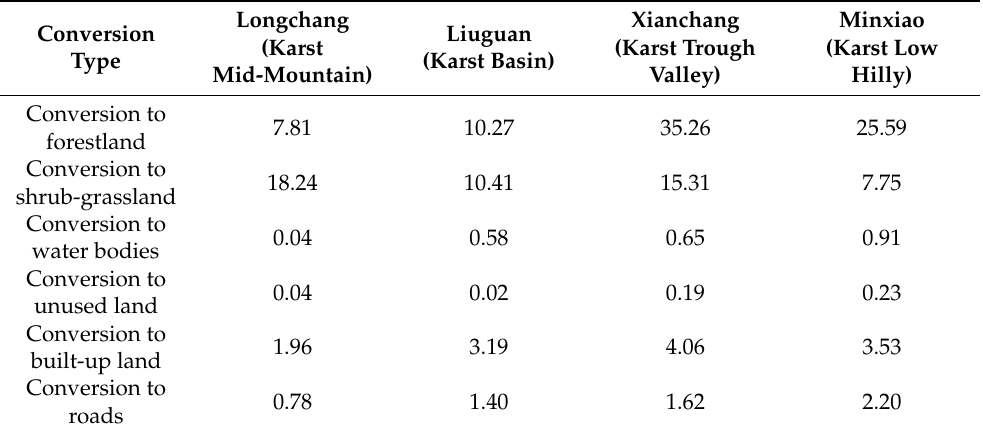
Table 5. The rate of conversion from cultivated land to each non-cultivated land type from 2010 to 2020